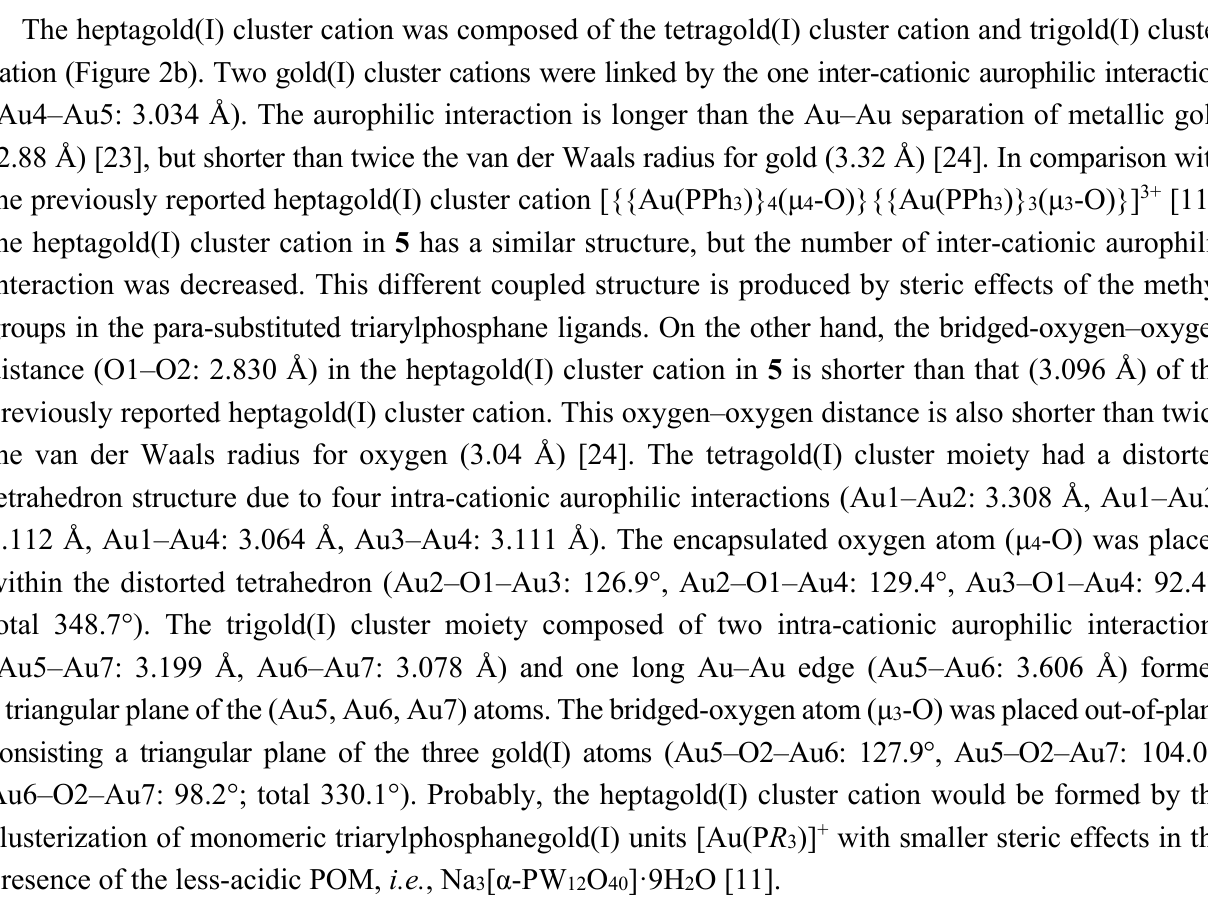
Table 2. The solid-state CPMAS 31 P NMR of 1 observed two broad signals at −3.4 and 24.4